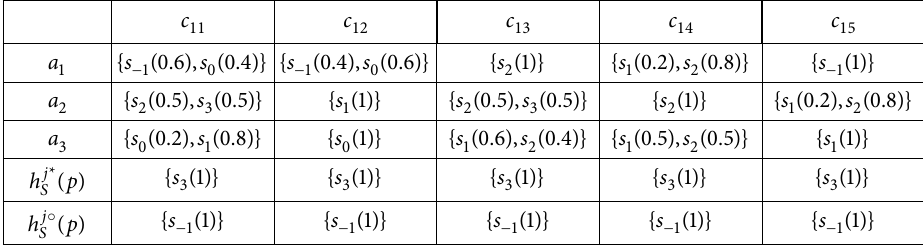
Table 1. The evaluation information of basic research